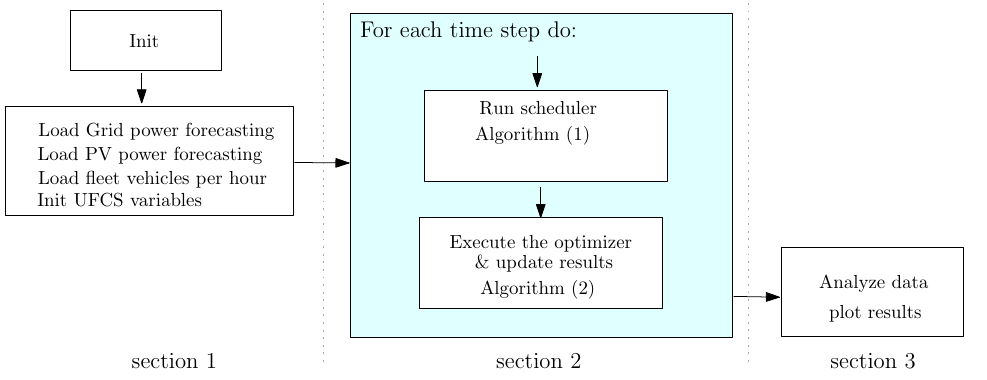
Figure 4. Structure of the developed